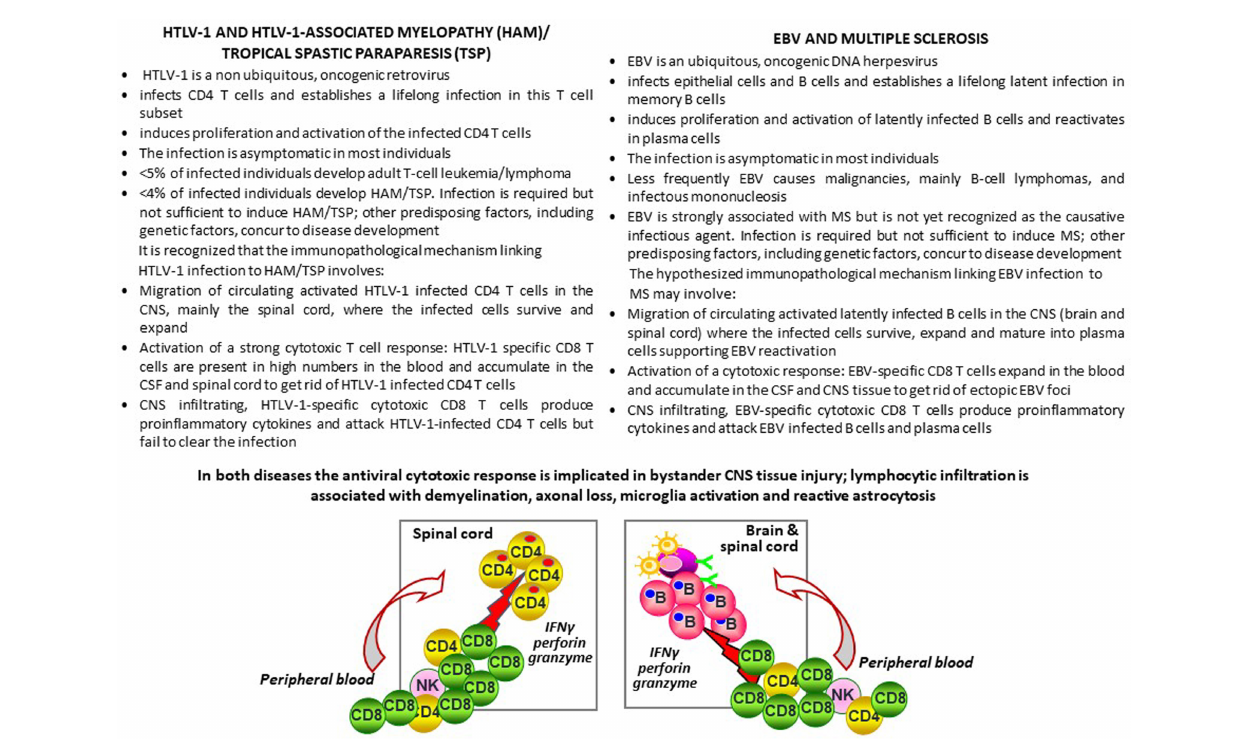
FIGURE 2 | HTLV-1 associated myelopathy/tropical spastic paraparesis and multiple sclerosis: Two chronic CNS in fl ammatory diseases, two viruses, a common immunopathologic mechanism? The text of this fi gure summarizes the tropism, biology and pathogenic potential of HTLV-1 and EBV and their association with HAM/ TSP and MS, respectively. The HTLV-1-mediated immunopathological model of HAM/TSP is presented vis-a-vis the hypothesized EBV-mediated immunopathological model of MS. The left side of the sketch depicts the migration of HTLV-1-infected CD4 T cells and the activation of a cytotoxic response towards HTLV-1-infected CD4 T cells in the spinal cord in HAM/TSP, leading to production of the pro-in fl ammatory cytokine IFN g and the lytic enzymes granzyme B and perforin, which play a key role in bystander tissue injury. On the right side of the sketch, a similar virus-driven immunopathological mechanism involving EBV- infected B cells and EBV-speci fi c CD8 T cells is proposed for